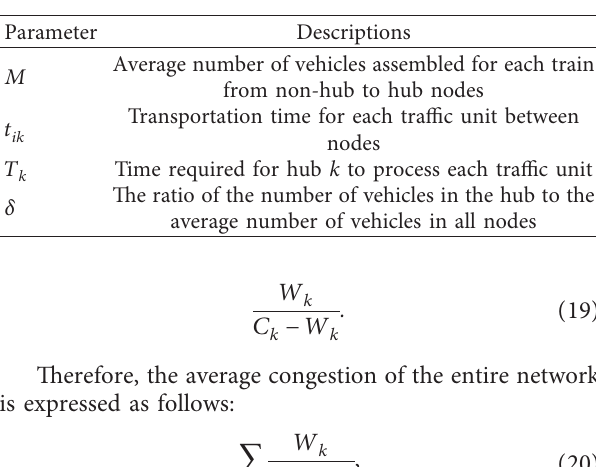
Table 5: The variables used for modelling the transportation time function.